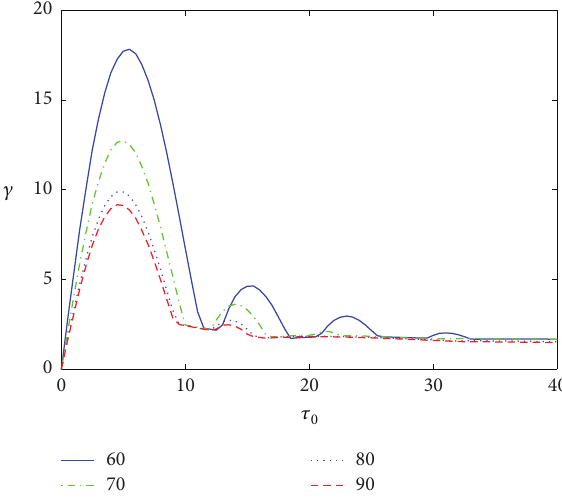
Figure 5: The effect of the frequency parameter ratio of system on the two-dimensional shock response spectrum of critical compo- nents, where 𝜑 0 = 60 ∘ , 𝛽 ̈𝑢 0𝑚 = 0.1 , and 𝜆 2 = 0.01 .